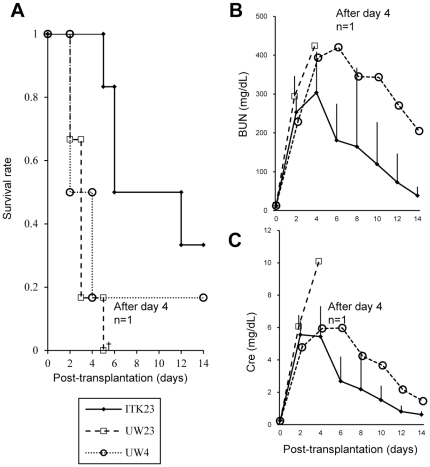
Survival rate, blood urea nitrogen (BUN) and serum creatinine (Cre) levels in experiment 3.(A): Preservation with ITK at 23°C (ITK23) tended to increase the survival rate compared to UW at 4°C (p = 0.09) and UW at 23°C (p<0.01). (B): BUN and Cre levels of all surviving rats were gradually recovered to a normal range by day 14 after RTx. (BUN and Cre levels of the UW4 group were based on a single animal after day 4.)